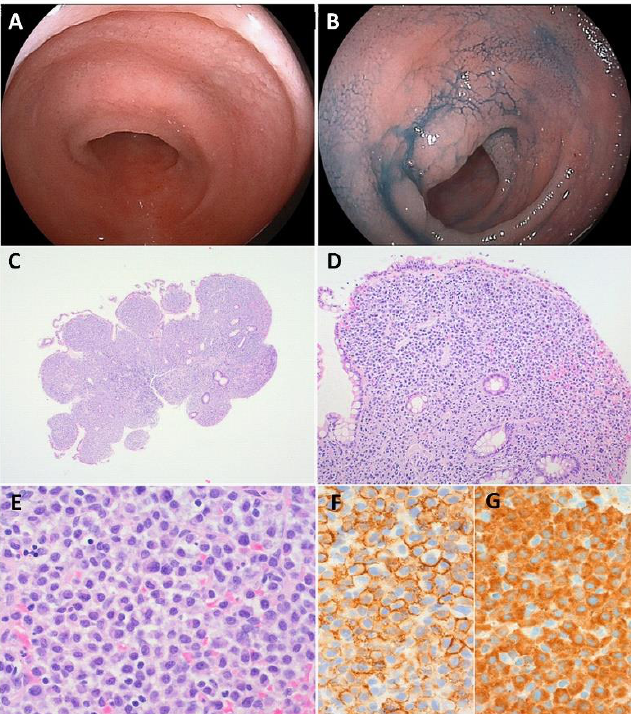
Figure 2. Immunoproliferative small intestinal disease (IPSID). ( A , B ) Double-balloon endoscopy showing villous edema in the ileum. ( C ) A biopsy specimen revealing blunting of the villi. ( D , E ) A dense lymphoplasmacytic infiltrate detected. ( F , G ) The tumor cells are positive for CD138 ( F ) and IgA ( G ). Original magnification: ×25 ( C ), ×100 ( D ), and ×400 ( E – G ).